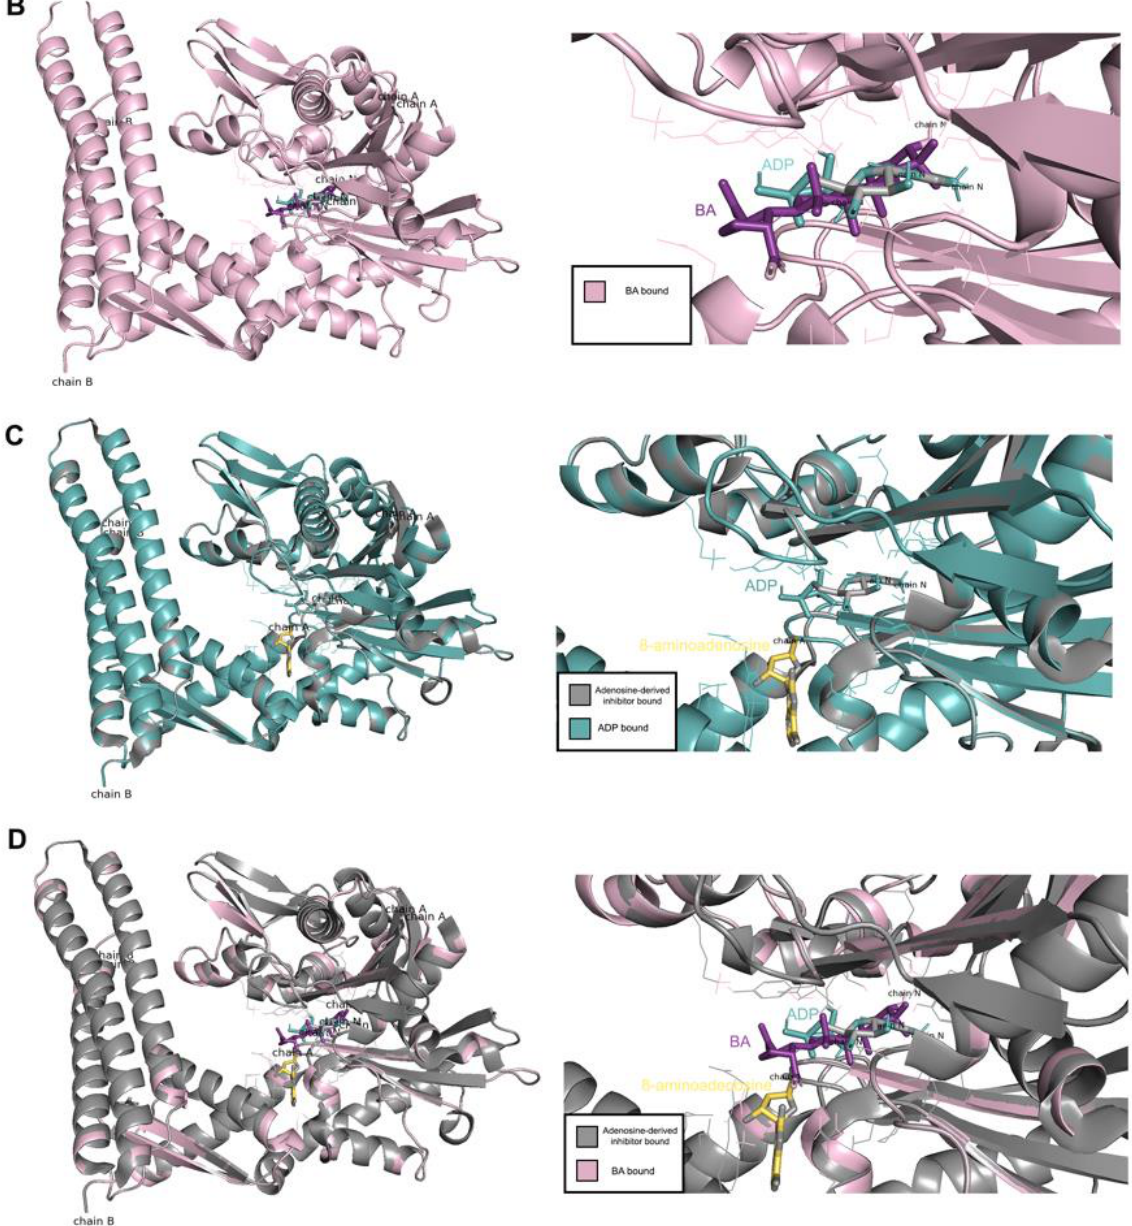
Figure 9. Comparison between the docking of BA and adenosine-derived inhibitor, ( A ) BA and ADP-bound structure, ( B ) adenosine-derived inhibitor and ADP-bound structure ( C ) as well as BA and adenosine-derived inhibitor and ADP-bound structure ( D ).